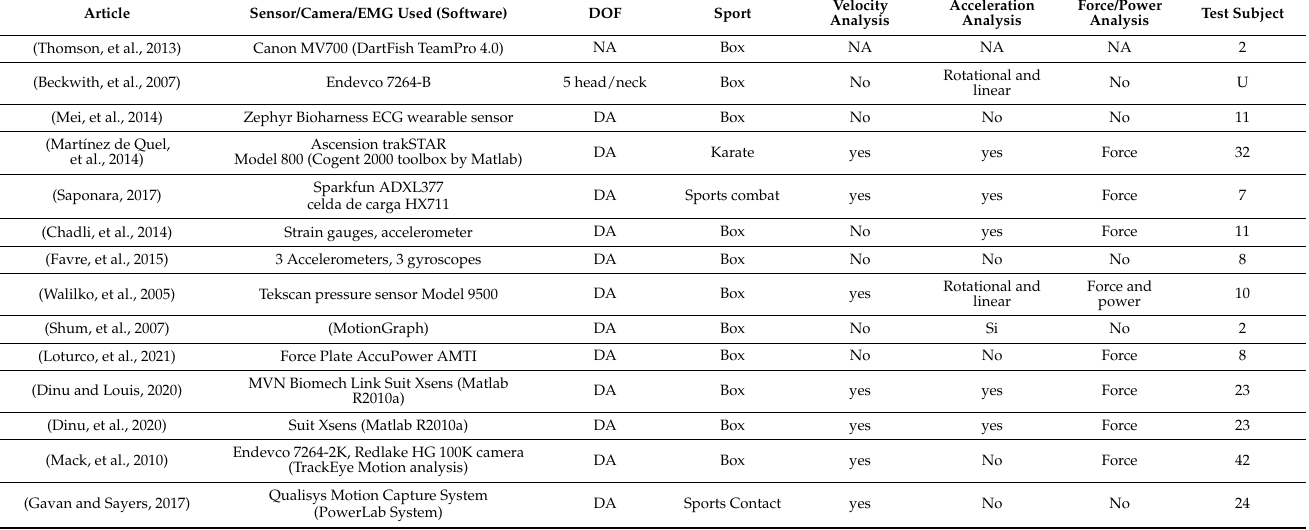
Table 2. Most relevant articles, devices used, and methodologies used [13,20,21,23,25,27,30–37].